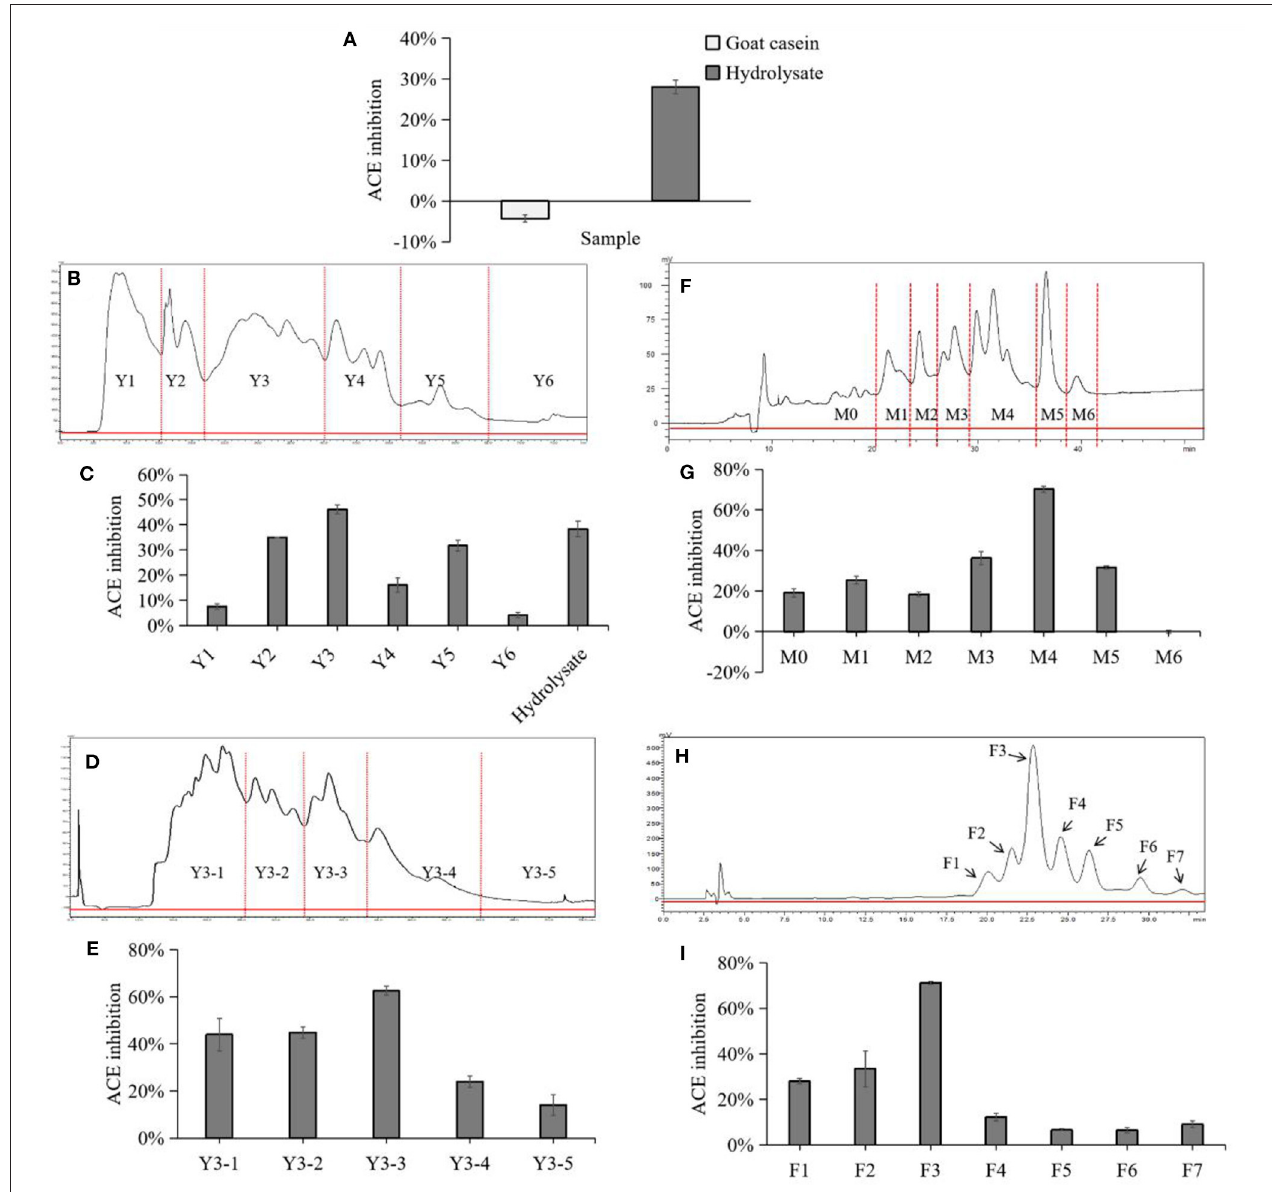
FIGURE 1 | Chromatogram and ACE inhibitory activity of each fraction in separation and purification. (A) Comparison of ACE-inhibitory activity before and after casein hydrolysis. (B) Preparative HPLC chromatograph of goat milk casein hydrolysates in the first fractionation. Fractions were termed with Y1 to Y6 followed by a number. (C) ACE-inhibitory ratios of the collected fractions after the first fractionation and hydrolysate. (D) Preparative HPLC chromatograph of goat milk casein hydrolysates in the second fractionation. (E) ACE-inhibitory ratios of the collected fractions by the second fractionation. Fractions were termed with Y3-1 to Y3-5 followed by a number. (F) Preparative HPLC chromatograph of goat milk casein hydrolysates in the third fractionation. (G) ACE-inhibitory ratios of the collected fractions by the third fractionation. Fractions were termed with M0 to M6 followed by a number. (H) Separation of the active fraction M4 by analytical RP-HPLC. (I) ACE-inhibitory ratios of the collected peaks, and peaks were numbered sequentially from F1 to